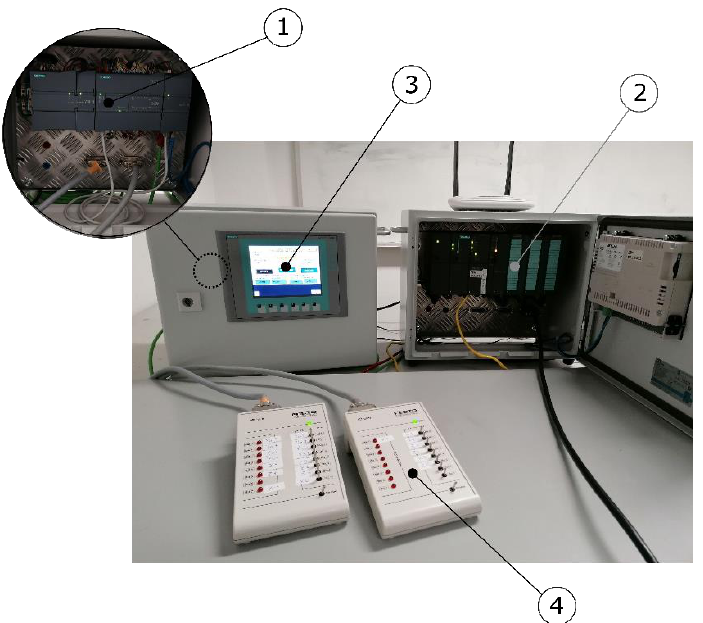
Figure 12. Laboratorial setup — PLCs controllers. 1-Siemens S7-1200; 2-Siemens S7-300; 3-SIEMENS KTP600 Basic Color PN; 4-FESTO Input/Output Simulator.